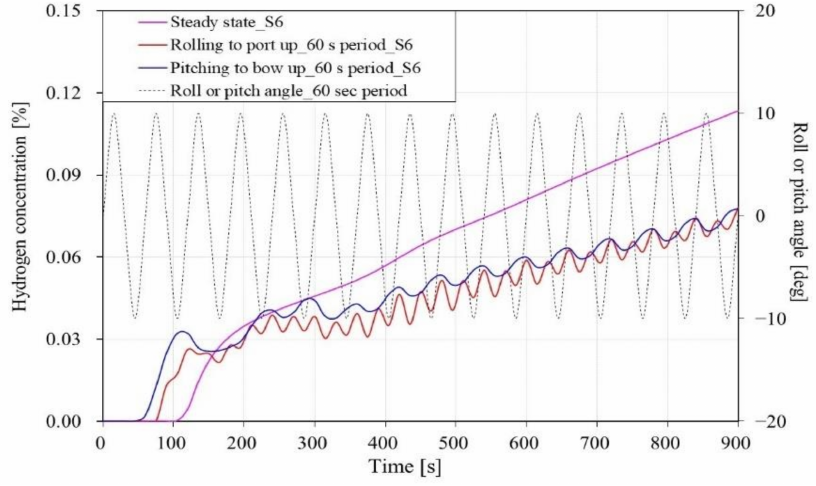
Figure 10. Hydrogen concentration by roll or pitch motion at